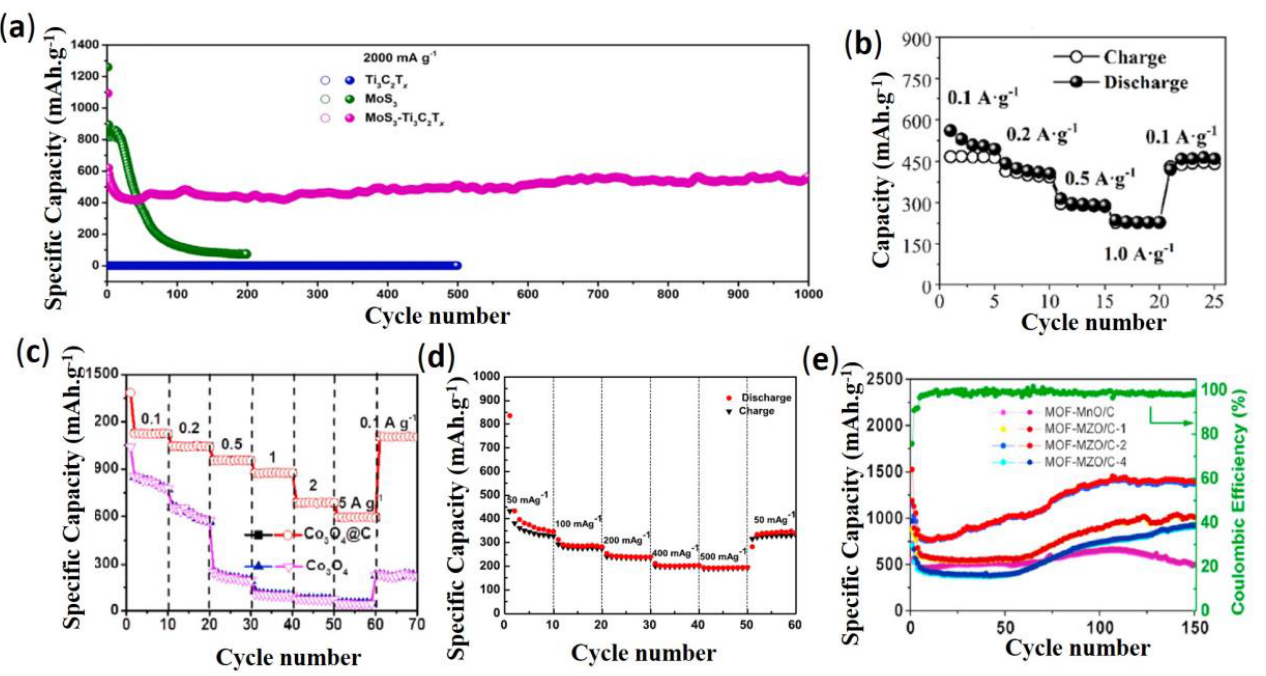
Figure 5. ( a ) Cycling performance of MoS 3 -Ti 3 C 2 T x at 2000 mA · g − 1 [115], ( b ) Rate capability of CoO/Co 1.94 P@CP [116], ( c ) Rate performance of Co 3 O 4 @C and bare Co 3 O 4 at various current densities from 0.1 to 5 A · g − 1 in the voltage range of 0.01–3.0 V [117], ( d ) Rate performance of TiO 2 /C composite-fibers electrode at various current densities from 50 mA · g − 1 to 500 mA · g − 1 over 10 cycles [118], and ( e ) Cycling tests of MOF-MnO/C and MOF-MZO/C electrodes at 0.2 A · g − 1 [119].